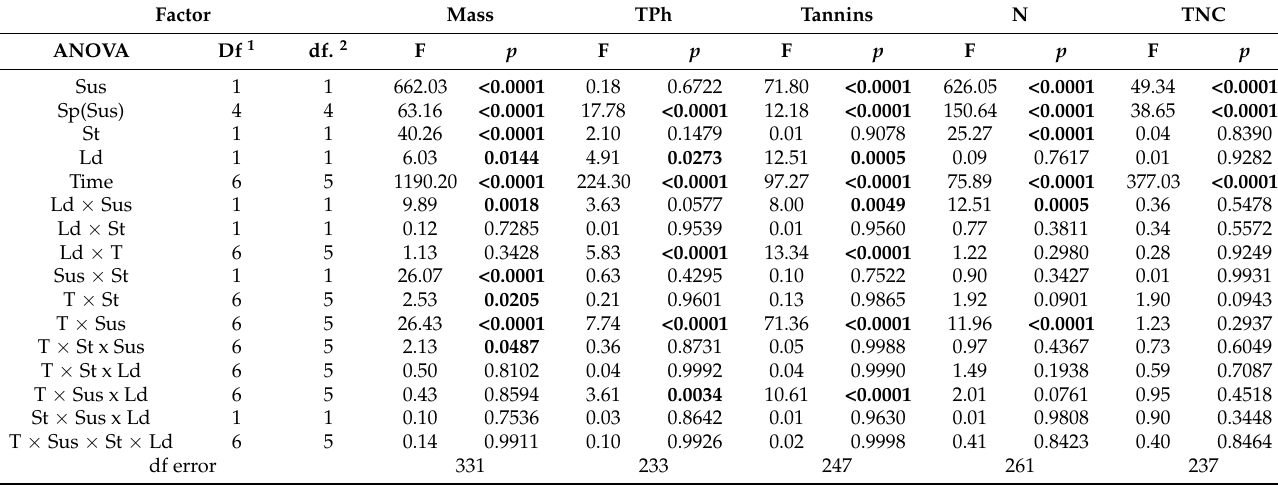
Table 2. Influence of susceptibility (Sus; resistant and susceptible), understory plant species (Sp) nested in Sus, stand species (St; oak and pine), and leaf damage (Ld; C, control; D, damaged) and leaf decomposition time (T), on remaining mass calculated for the whole research period in relation to initial mass (%), content of total phenols (TPh; expressed as µ M of chlorogenic acid g − 1 d.m.), condensed tannins (Tannins; expressed as µ M of catechin g − 1 d.m.), nitrogen (N, % d.m.), and total nonstructural carbohydrates (TNC, % d.m.) in leaf litter. For the ANOVA, the results of all seven terms ( 1 ) were used to assess the remaining mass, and for other parameters a maximum of six terms ( 2 ) (details in Materials and Methods). p -values < 0.05 are indicated in